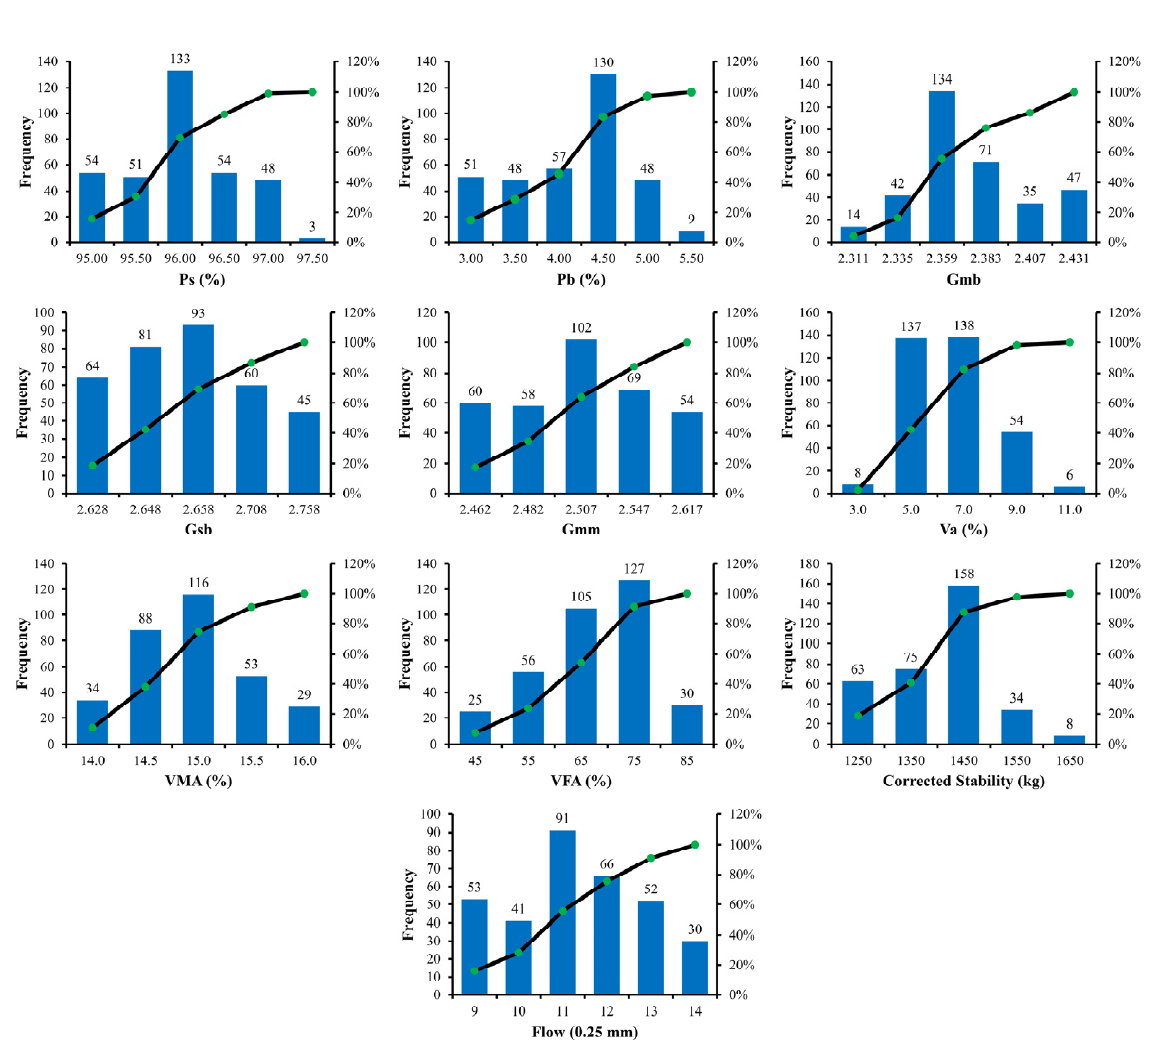
Figure 2. Distribution of input parameters for AWC.